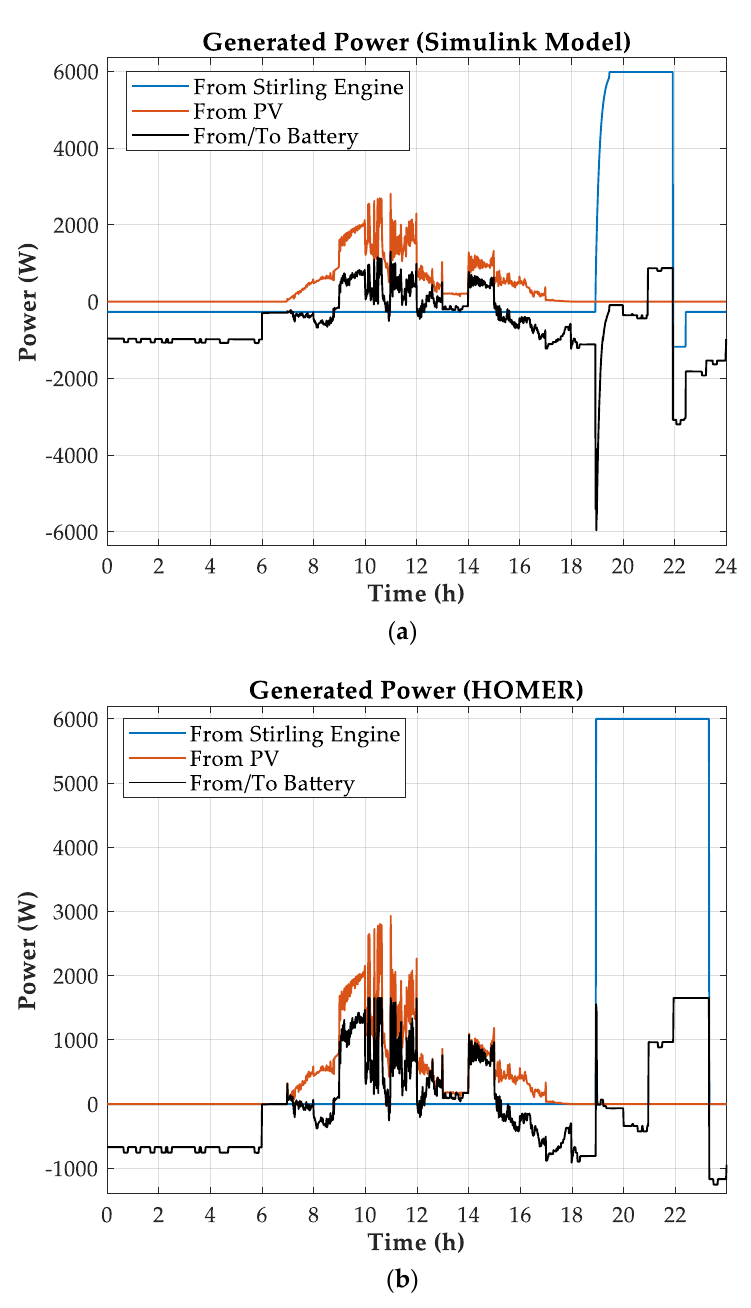
Figure 15. Electricity generation during winter solstice by component of the PV / Stirling / battery system regarding ( a ) Simulink model and ( b ) HOMER simulation.